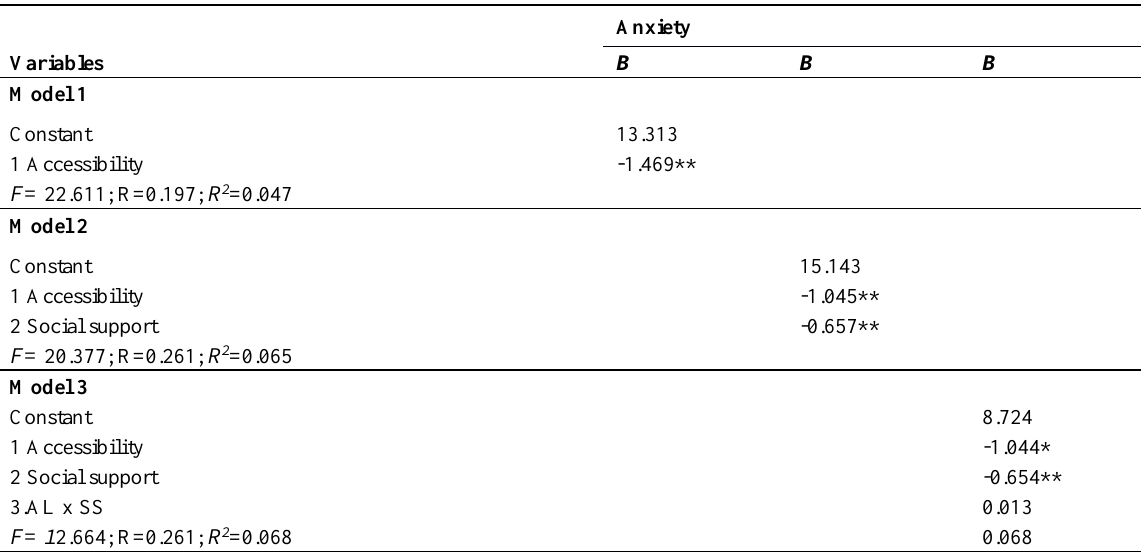
Table 3: Model test